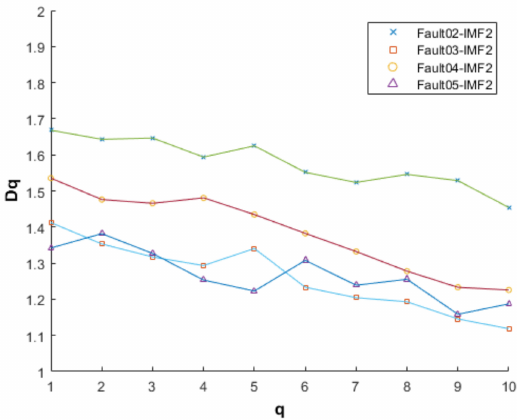
Figure 17. IMF2‑VMD box fractal dimension